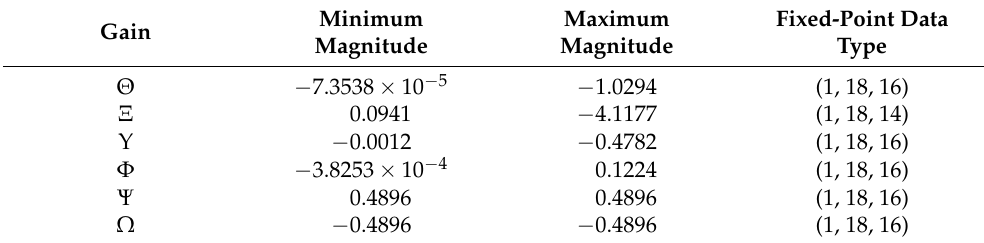
Table 1. Gain matrices with value magnitude ranges and assigned fixed-point data types.